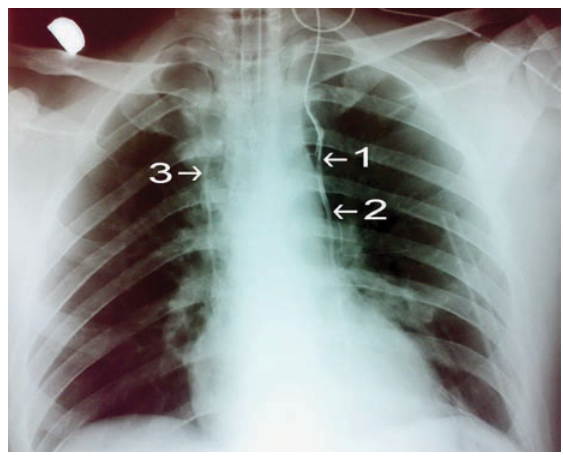
Figure 1. Chest radiograph showing malpositioned central venous